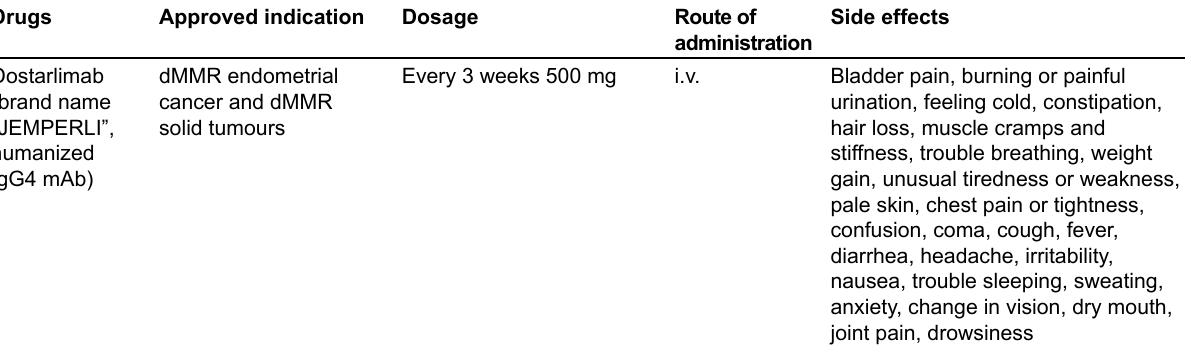
Table 1. Currently available drugs that target PD-1/PD-L1 pathway ( continued ) Drugs